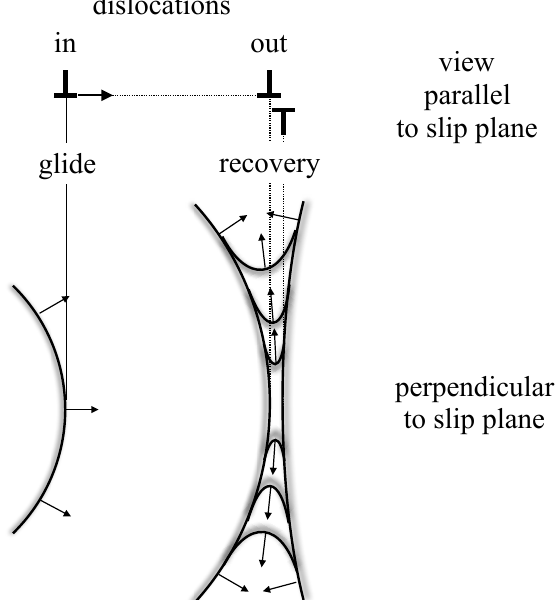
Figure 1. Scheme of dislocation glide with generation and storage of dislocations (’dislocations in’) and dynamic recovery of dislocations (’dislocations out’) viewed perpendicular and parallel to glide